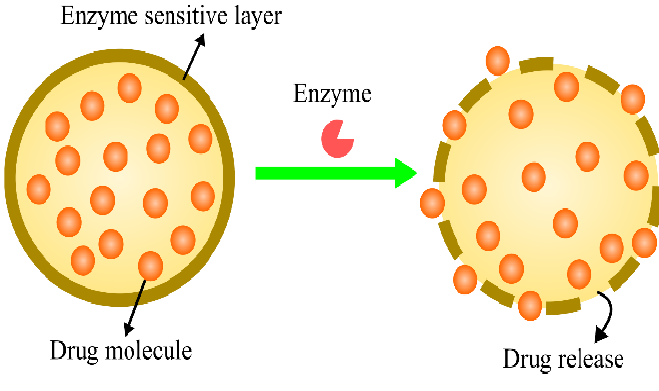
Figure 5. Enzyme responsive drug delivery